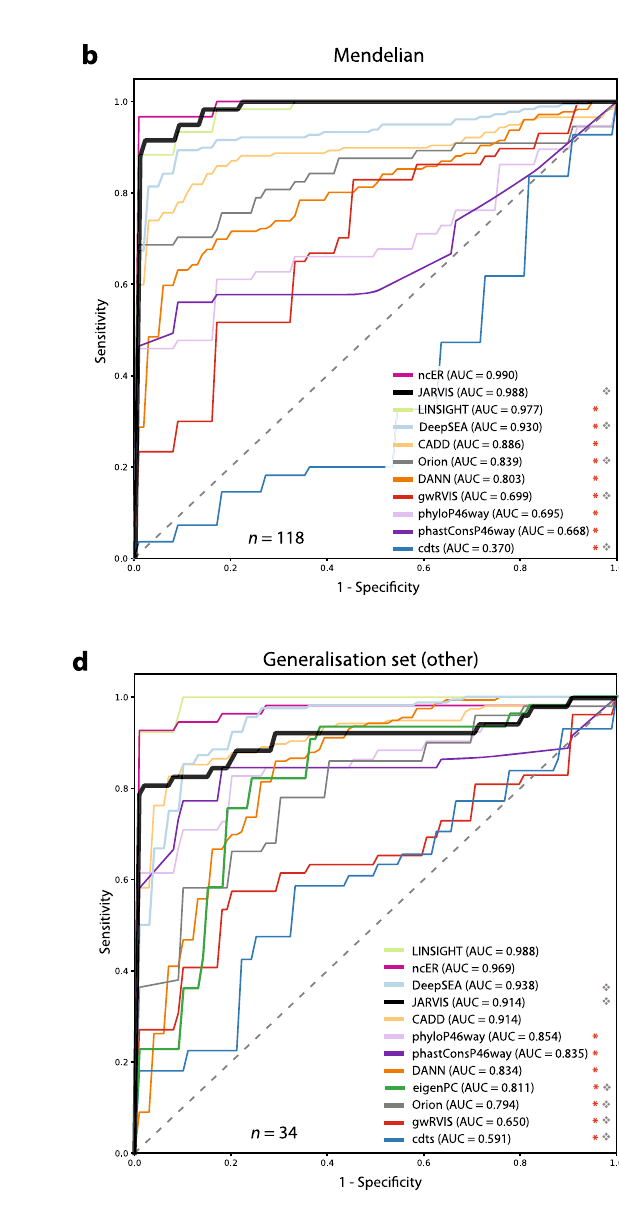
Fig. 5 JARVIS performance on validation sets. ROC curves from prediction on different sets of noncoding variants (falling into intergenic regions, UTRs, lincRNAs, UCNEs, and VISTA enhancers) not used during JARVIS training. In each case, a benign set of equal size has been randomly subset from the denovo-db control variants, avoiding any overlaps with the pathogenic variants in each of the validation sets. a GWAS hit SNVs ( n = 1262). b Noncoding variants with mendelian traits ( n = 118). c Generalization test set (ncRNA; n = 70). d Generalization test set (other; n = 34). In each plot, n refers to the total size of the validation set, including both pathogenic variants and a sample of control variants of equal